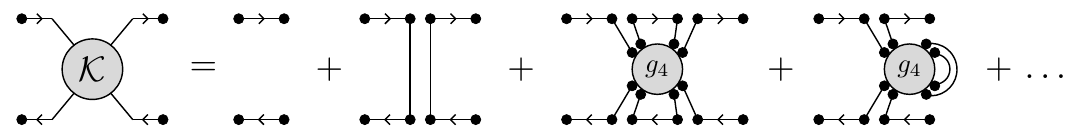
Figure 5 . Some exemplary diagrams in a theory with quartic potential contributing to